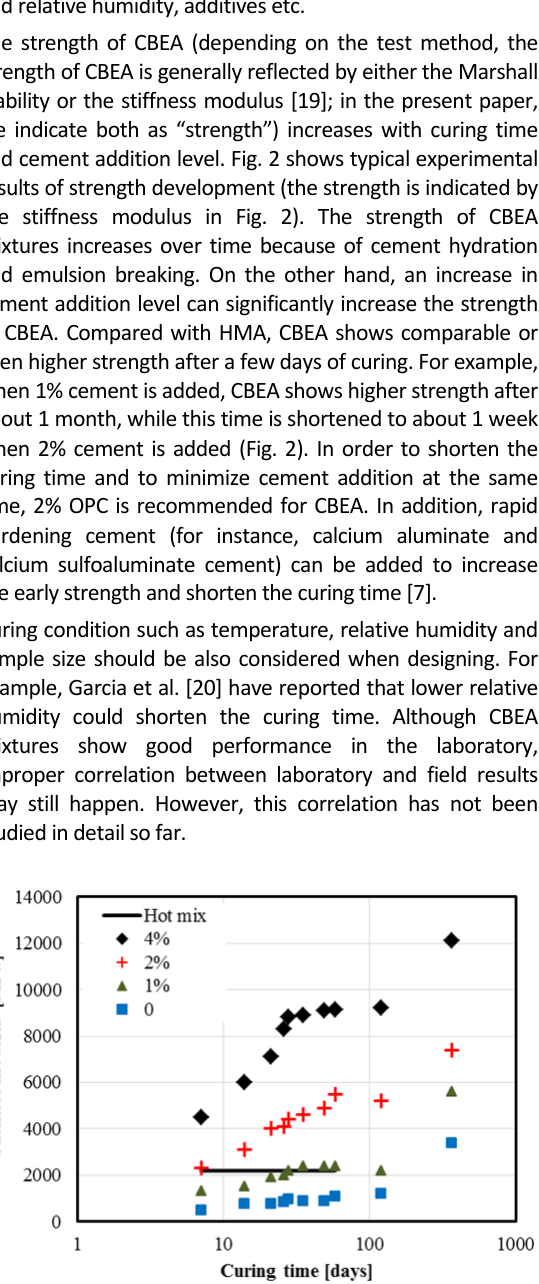
Figure 2. Strength development of CBEA mixture over time (adapted from [19], legend in the figure shows cement addition level, data obtained by indirect tensile